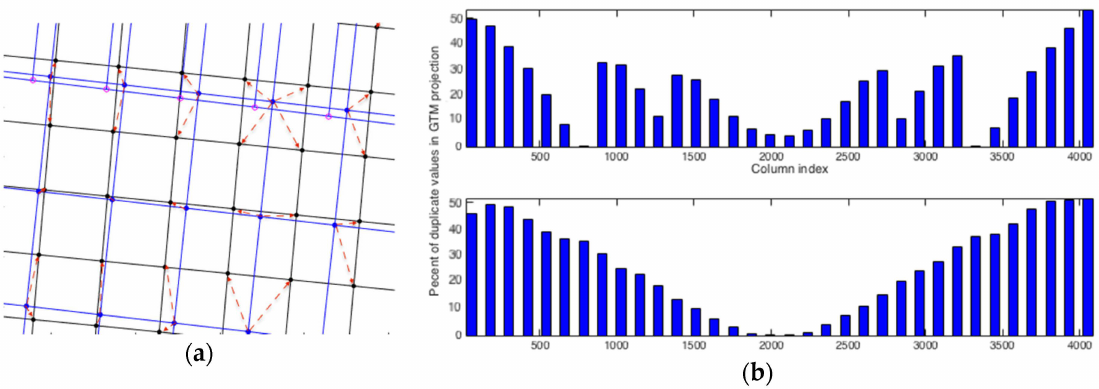
Figure 14. ( a ) Small crop from the end of the swath showing both grids: original swath (blue) and GTM (black). Pixels deleted onboard (magenta) would decrease the number of duplications in the GTM projection; ( b ) Distribution of GTM duplicates: ( top ) horizontal and ( bottom ) vertical. The bar graph uses 121 columns in each bin, except for the last